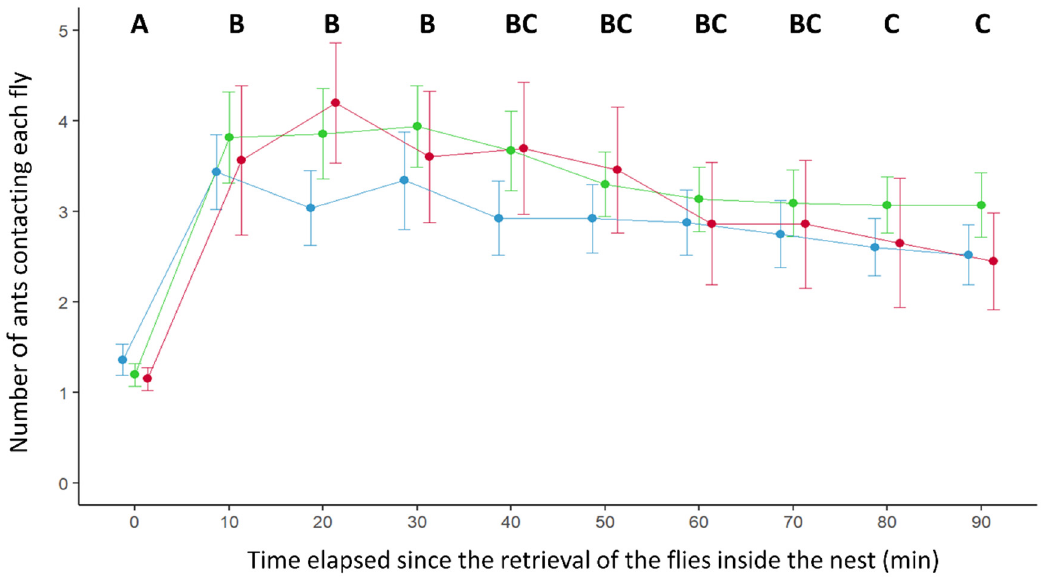
Figure 3. Number of ants contacting each fly inside the nest as a function of the time elapsed since its retrieval. Blue: control flies (n = 51), green: conidia-covered flies (n = 51), red: flies killed by the entomopathogenic fungus (n = 34). The points represent the mean; the bars represent confidence intervals (95%) for each condition. Time steps sharing a common letter were not significantly different.